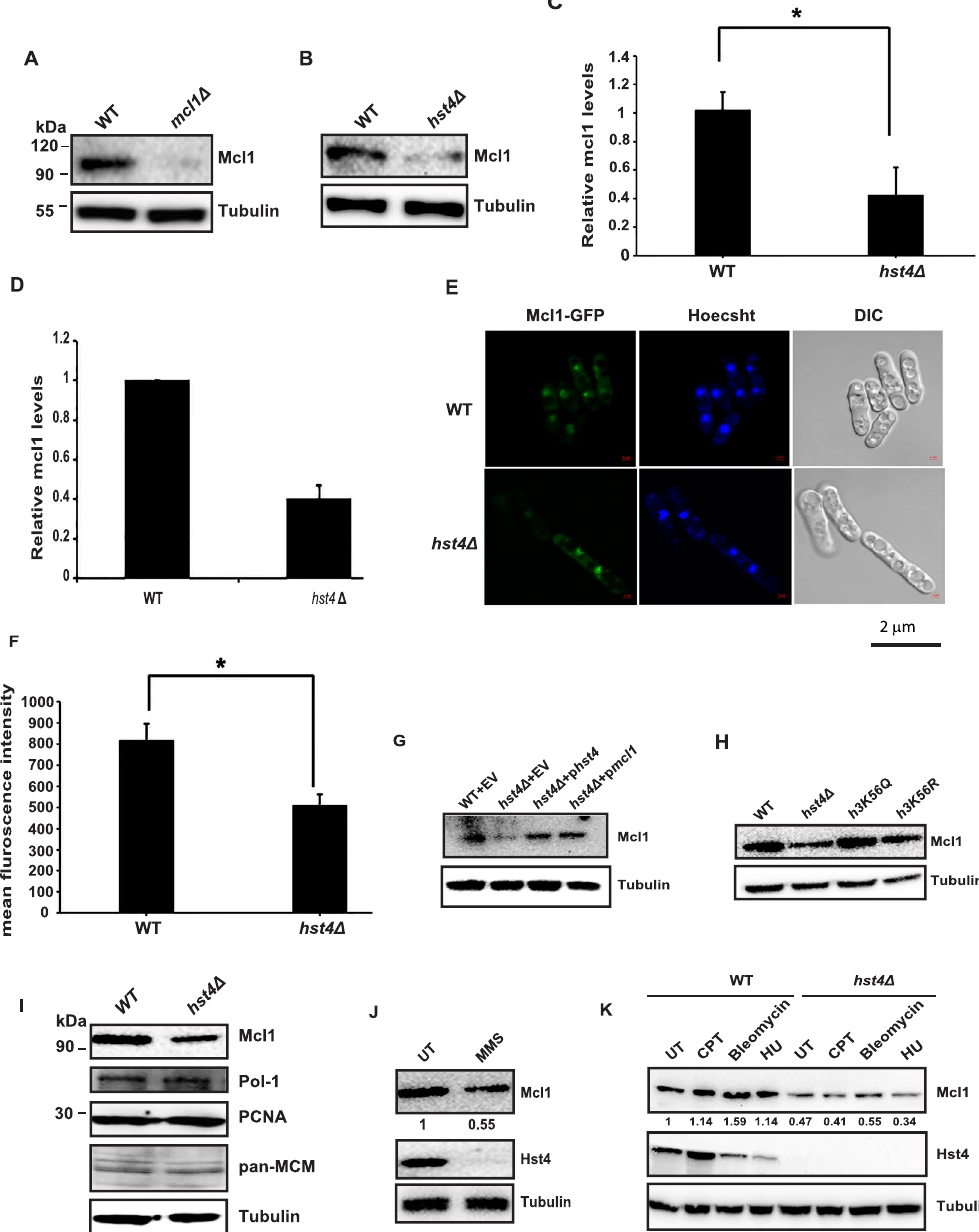
Figure 7. Hst4 regulates mcl1 expression. ( A , B ) Wild type (ROP191), hst4 ∆ (ROP58) and mcl1 ∆ (NYSPE19) strains were grown asynchronously to mid log phase in YES medium. Whole cell lysates were prepared and the levels of Mcl1 were monitored by Western blotting using anti-And-1 antibody. ( C ) The Mcl1 levels in WT and hst4 Δ mutants were quantified relative to tubulin levels by densitometric analysis using Image J software. Error bars: standard deviation of the mean of densitometry values (three independent experiments). Statistical significance p < 0.05 between WT and hst4 Δ strains is indicated with a single asterisk. ( D ) qPCR quantification of mcl1 levels in WT and hst4 Δ mutants normalized with actin levels. Error bars represent standard deviation. ( E ) Live cells of wild type (YAP50) and hst4 Δ mutant cells bearing endogenous GFP tagged mcl1 gene (DHP57) were visualized under confocal microscope. Bar = 2 µ m. ( F ) Quantification of nuclear GFP signal in wild type versus hst4 Δ described in ( D ). The intensity of Mcl1-GFP foci was analyzed using Image J software. Approximately 50 cells from three independent experiments against each genotype is plotted. Statistical significances between WT and hst4 Δ indicated with single asterisk, p < 0.05. ( G ) Cell lysates from wild type strain (ROP191) or hst4 ∆ (ROP58) expressing hst4 , mcl1 or pSLF272 (empty vector) were prepared and Mcl1 levels were analyzed by Western blotting using anti-And-1 antibody. ( H ) Logarithmically grown cultures of WT (ROP191), hst4 Δ (ROP58), h3K56Q (ROP247) and h3K56R (ROP253) strains were lysed and Western blot was performed to check the levels of Mcl1. ( I ) WT(ROP191) and hst4 ∆ (ROP58) strains were grown asynchronously. Whole cell lysates were prepared and the levels of Mcl1, Pol1, PCNA, MCMs were monitored by Western blotting using individual antibodies. ( J ) Cell lysates from WT strains untreated or treated with